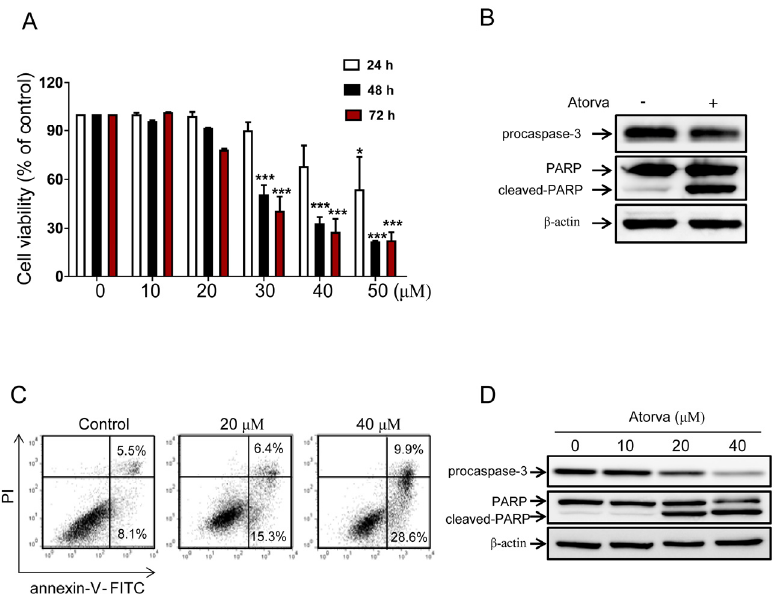
Figure 1. Cytotoxic effects of atorvastatin against T24 human bladder cancer